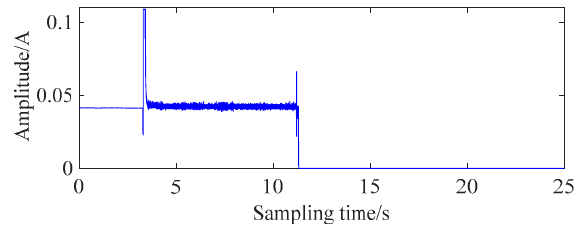
Figure 5. Signal of overload current.